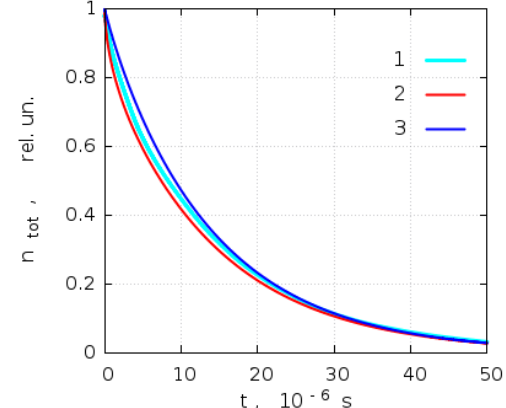
Figure 10: Decay of the total number of electrons in Si wafer s 1 after the turning off the blue light at t = 0 where curve 1 presents experimental data and curves 2 to 4 show simulation results obtained at τ R = 666 µ s (curves 2 and 3) and τ R = 20 µ s (curve 4) when τ S = 0 . 02 µ s, τ S = 5 . 6 µ s, and τ S = 0 . 056 µ s (curves 2, 3, and 4, respectively).